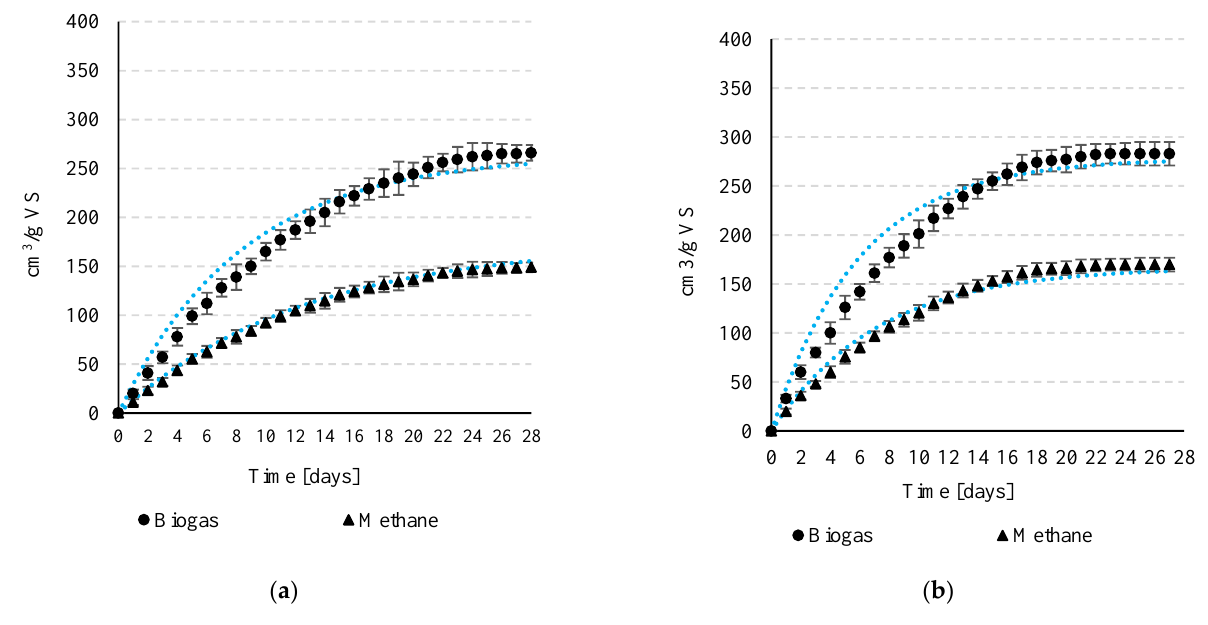
Figure 6. The course of anaerobic digestion in S2 depending on the experimental variant (( a ) variant 1; ( b ) variant 2).